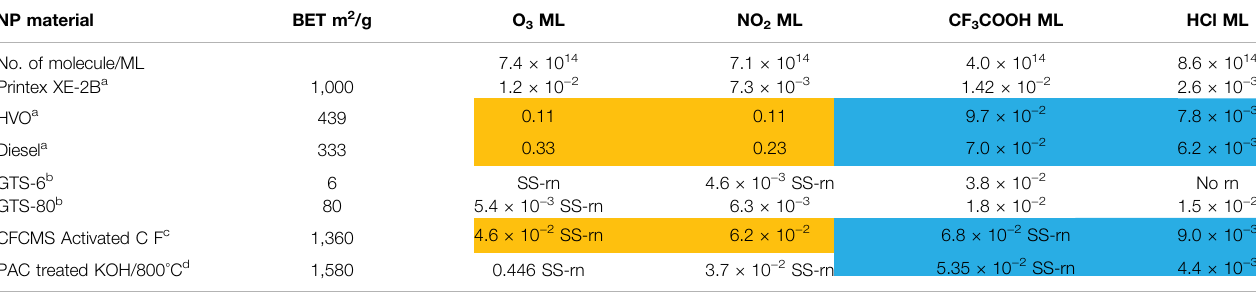
TABLE4| PartialtitrationresultsonsomeamorphouscarbontypesusingO 3 ,NO 2 asoxidizingandCF 3 COOH,HClasacidicprobegasesforthecompositionoftheinterface in terms of reducing (oxidizable) and basic surface functional groups in units of monolayers (ML). NP